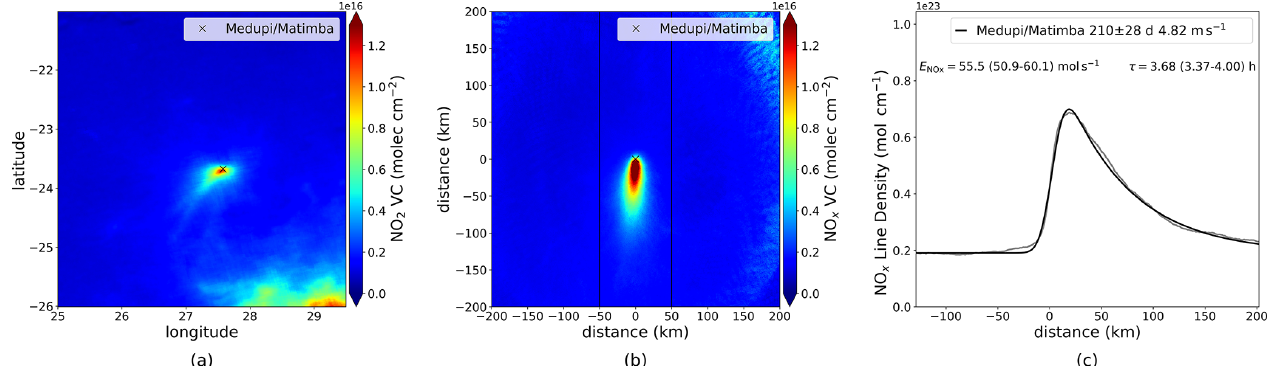
Figure 1. (a) Plot of the mean TROPOMI NO 2 tropospheric vertical column (VC) from 1 March 2018 to 29 February 2020 in the region of the power plants Medupi and Matimba in South Africa for days with wind speed > 2ms − 1 . (b) In this plot each NO 2 tropospheric VC is converted to an estimate of NO x VC and is rotated with its wind direction around the center of the source (cross) to an upwind– downwind pattern. The black lines indicate the sector of ± 50km around the source relevant for the emission and lifetime estimates. (c) NO x VC integrated perpendicular to the wind direction (NO x line density) as a function of distance to the source calculated for the ± 50km sector (gray) and fit results (black) with estimated NO x emissions and lifetime. Emission and lifetime uncertainties are 1 standard deviation retrieved by the fitting